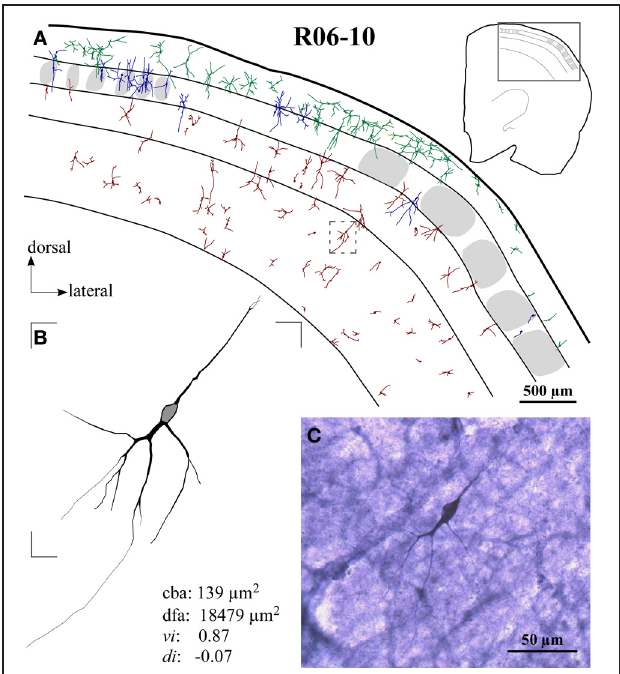
FIGURE 3 | Case R06-10. (A) All S1 nitrergic neurons in this 200 μ m-coronal section were reconstructed. Neurons with cell bodies located in different cortical layers are represented with different colors. Their spatial distribution does not follow any apparent pattern or regularity. Parts of the section lack the presence of nitrergic neurons while in other parts these neurons are clustered. The absence of barrels in the middle part of this section suggests a cut through two different barrel fields (probably the hindpaw and the postero-medial barrel subfields) separated by the barrel-free dysgranular cortex. Bushy supragranular (SG) neurons observed in this section are not consistently found in other sections of this hemisphere. Nevertheless, they are observed in the other hemispheres analyzed (see Figure 4 for another example). Note that in many instances, dendrites cross over laminar and/or columnar borders. Additionally, some layer IV barrels are devoid of nitrergic neurons, while in others nitrergic cell bodies are localized close to the external border of the barrel. The insert at the upper right corner illustrates the whole section in which a frame depicts the region enlarged in the main part of the figure. A small dashed box frames the neuron illustrated in (B) . (B) Neurolucida reconstruction of a typical vertically-oriented nitrergic neuron in layer VI. Morphometric parameters depicted for this neuron: cba, cell body area; dfa, dendritic field area; vi, vertically indices; di, directionally indices. Contour of cell body is delimited in gray. (C) High-magnification photomicrograph of the same neuron illustrated in (B) .